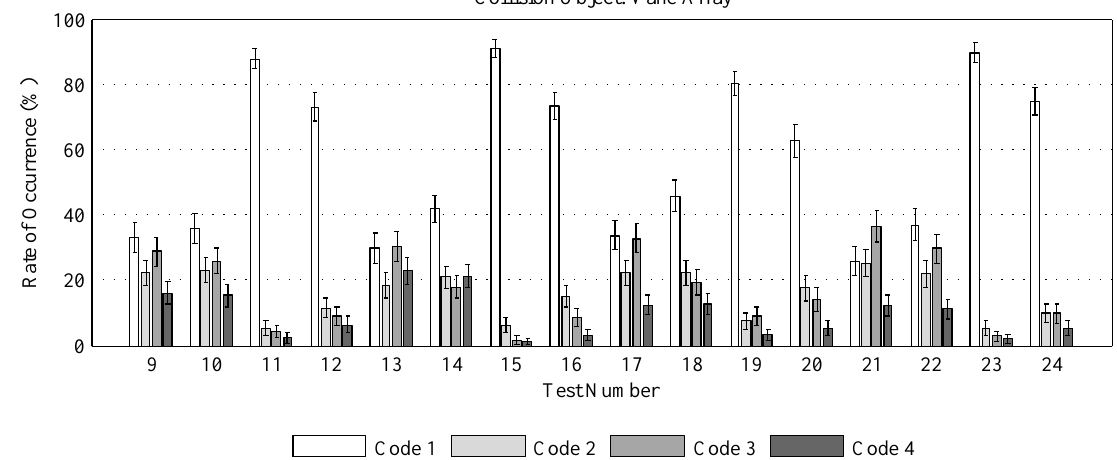
Figure 12. Summary of bead passage codes for vane array tests, showing 95% confidence interval of observed